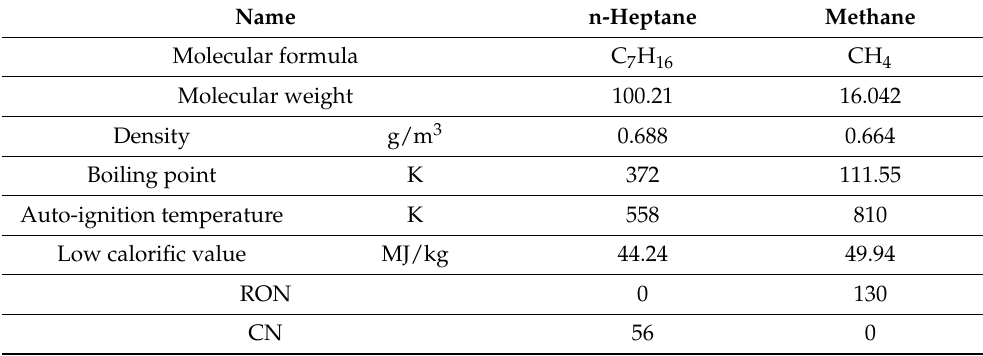
Table 2. Fuel properties.